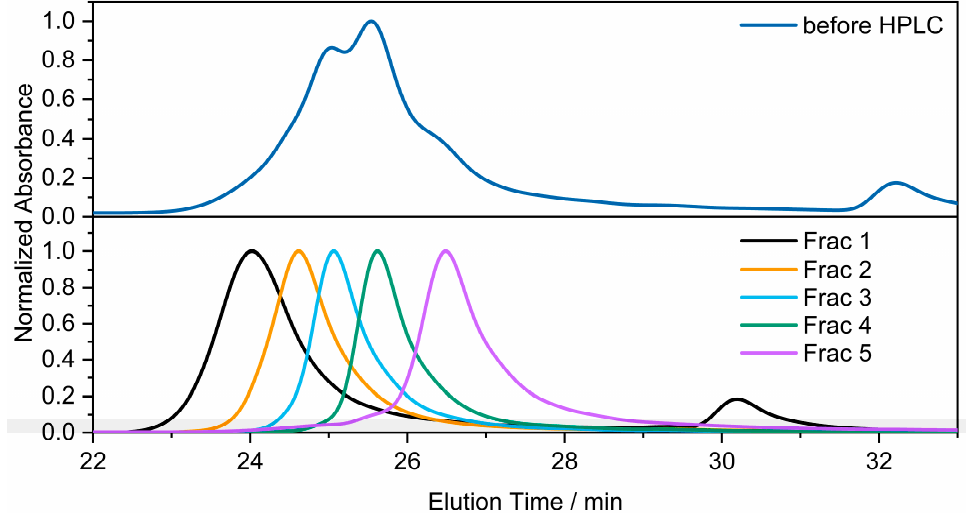
Figure 2. GPC traces of the crude sample ( up ) and the fractionated sample ( down ).